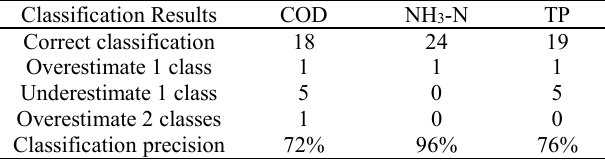
Table 3. Statistics of water quality classification